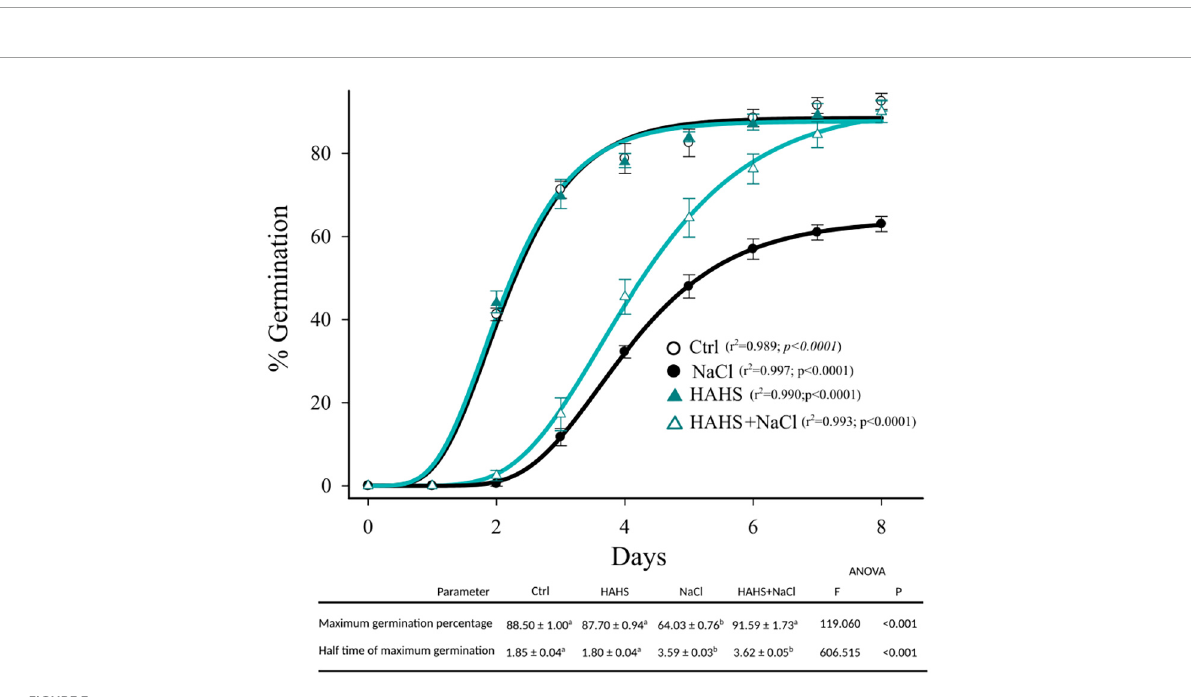
FIGURE3 Germination kinetics of HAHS-treated and control tomato seeds under saline conditions. Symbols represent the daily average germination percentage of four replicates with 100 seeds. Seed germination data were fitted to the Gompertz equation: f = ae inoculated under control (Ctrl) or habitat-adapted heterologous symbiont (HAHS) conditions with water free of NaCl or with 100 mmol NaCl (+NaCl) irrigation. Statistical significance was analyzed by a univariate analysis of variance. Lowercase letters denote statistical differences (pairwise test) among treatments for each